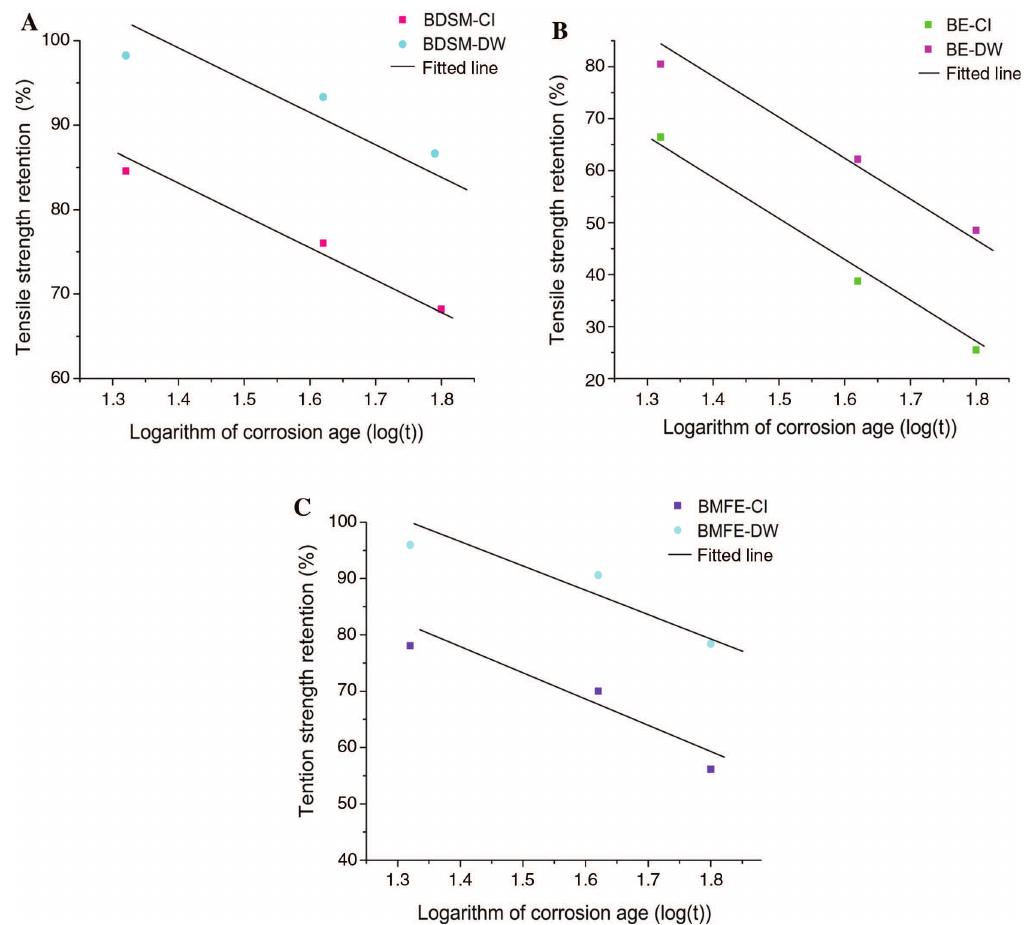
Figure 13: Fitted curves for degradation of fiber-reinforced polymer (BFRP) bars: (A) fitted curves for BDSM bars; (B) fitted curves for BE bars; (C) fitted curves for BMFE